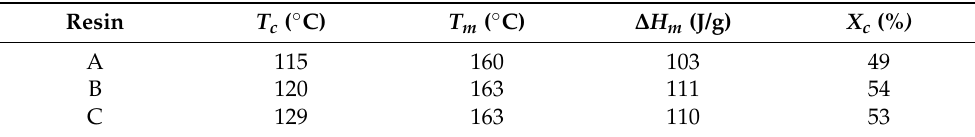
Table 5. Summarized DSC results for all three resins: peak crystallization temperature (T c ), peak melting temperature ( T m ), heat of fusion ( ∆ H m ), and percent crystallinity (X c ). Heating and